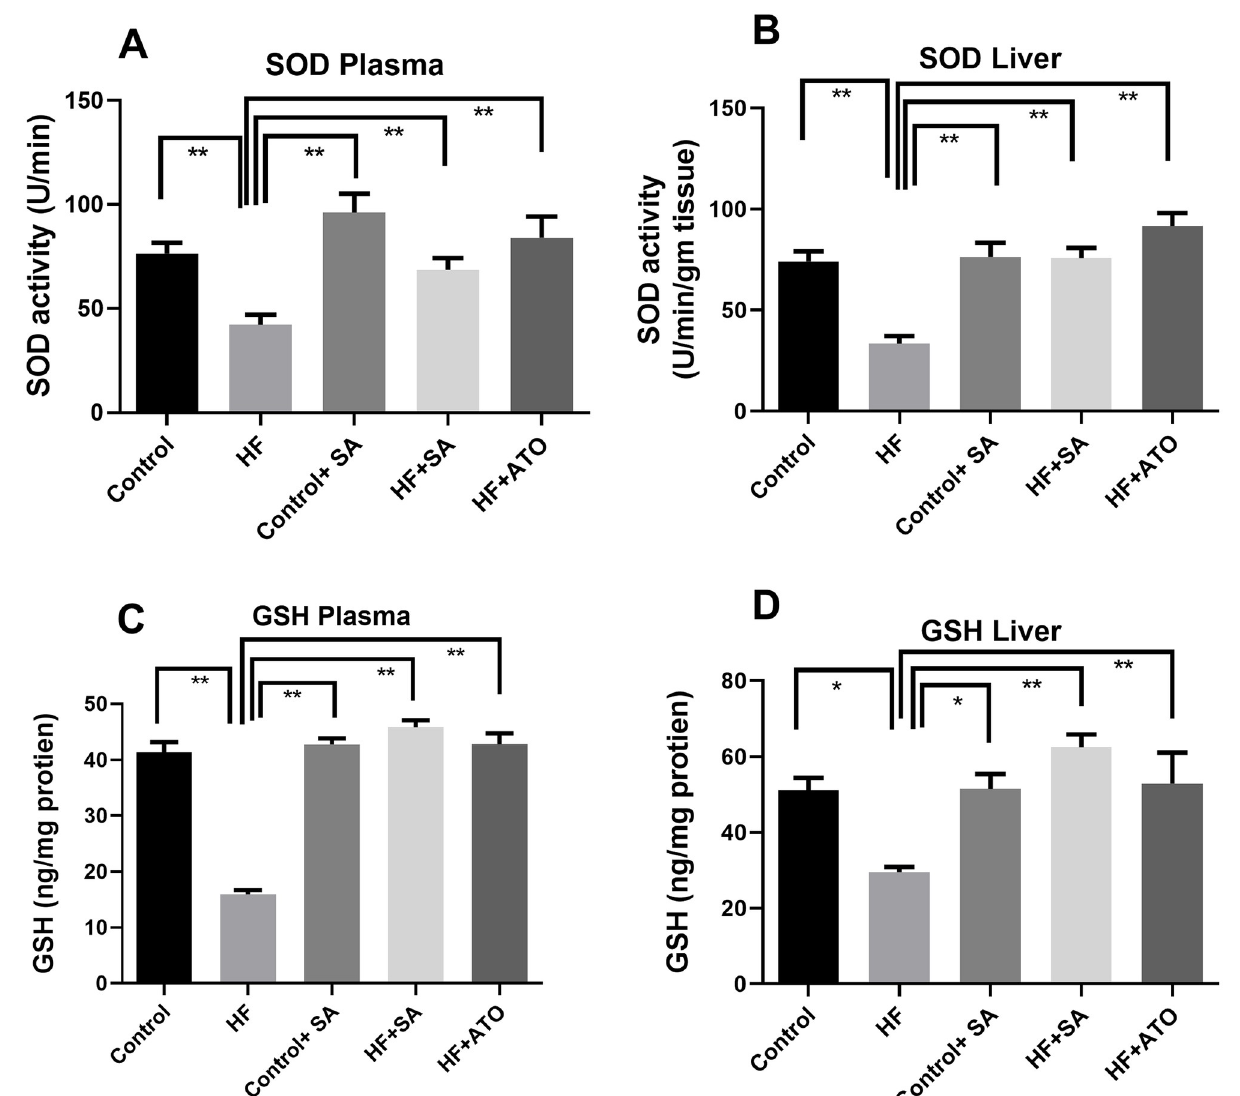
Fig 5. Effect of Senna alexandrina leaf supplementation on A. SOD in Plasma; B. SOD in Liver; C. GSH in Plasma and D. GSH in Liver in high fat diet induced obese rats. Values are presented as mean ± SEM, n = 8. One-way ANOVA followed by Tukey’s multiple comparisons test was done for statistical comparison. � represents p � 0.05; �� represents p �